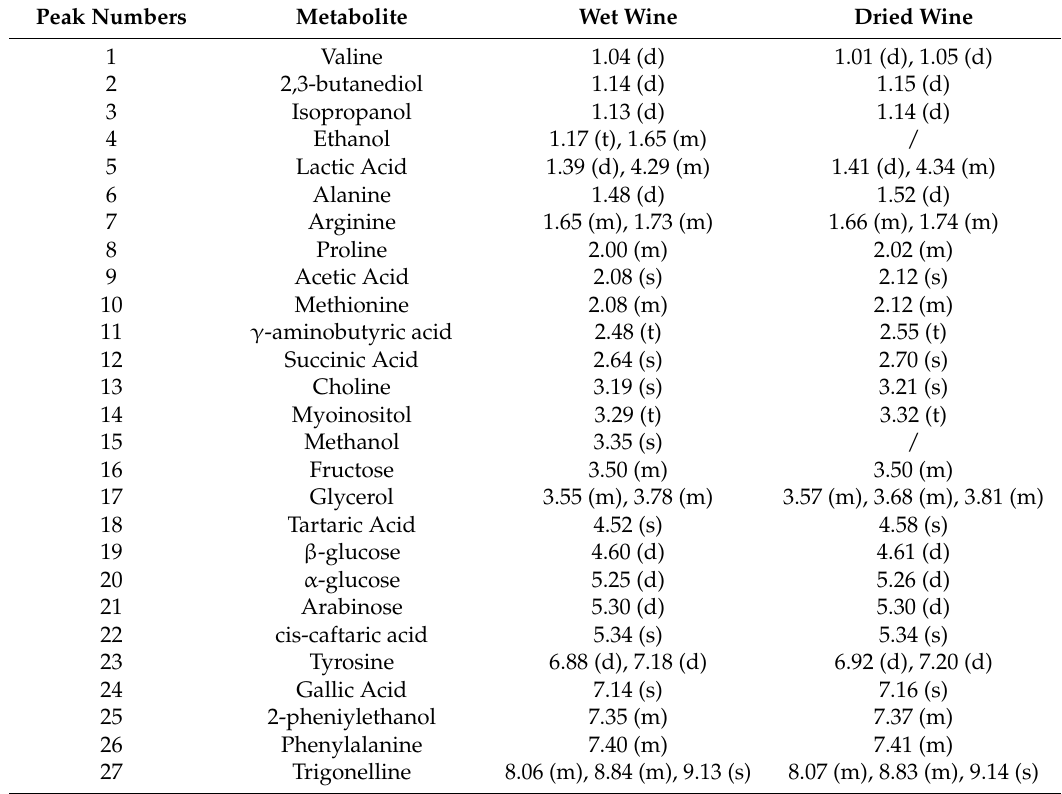
Table 1. List of the metabolites identified in the 1 H-NMR spectra of wet and dried wines. The chemical shifts and multiplicity of the assignments are